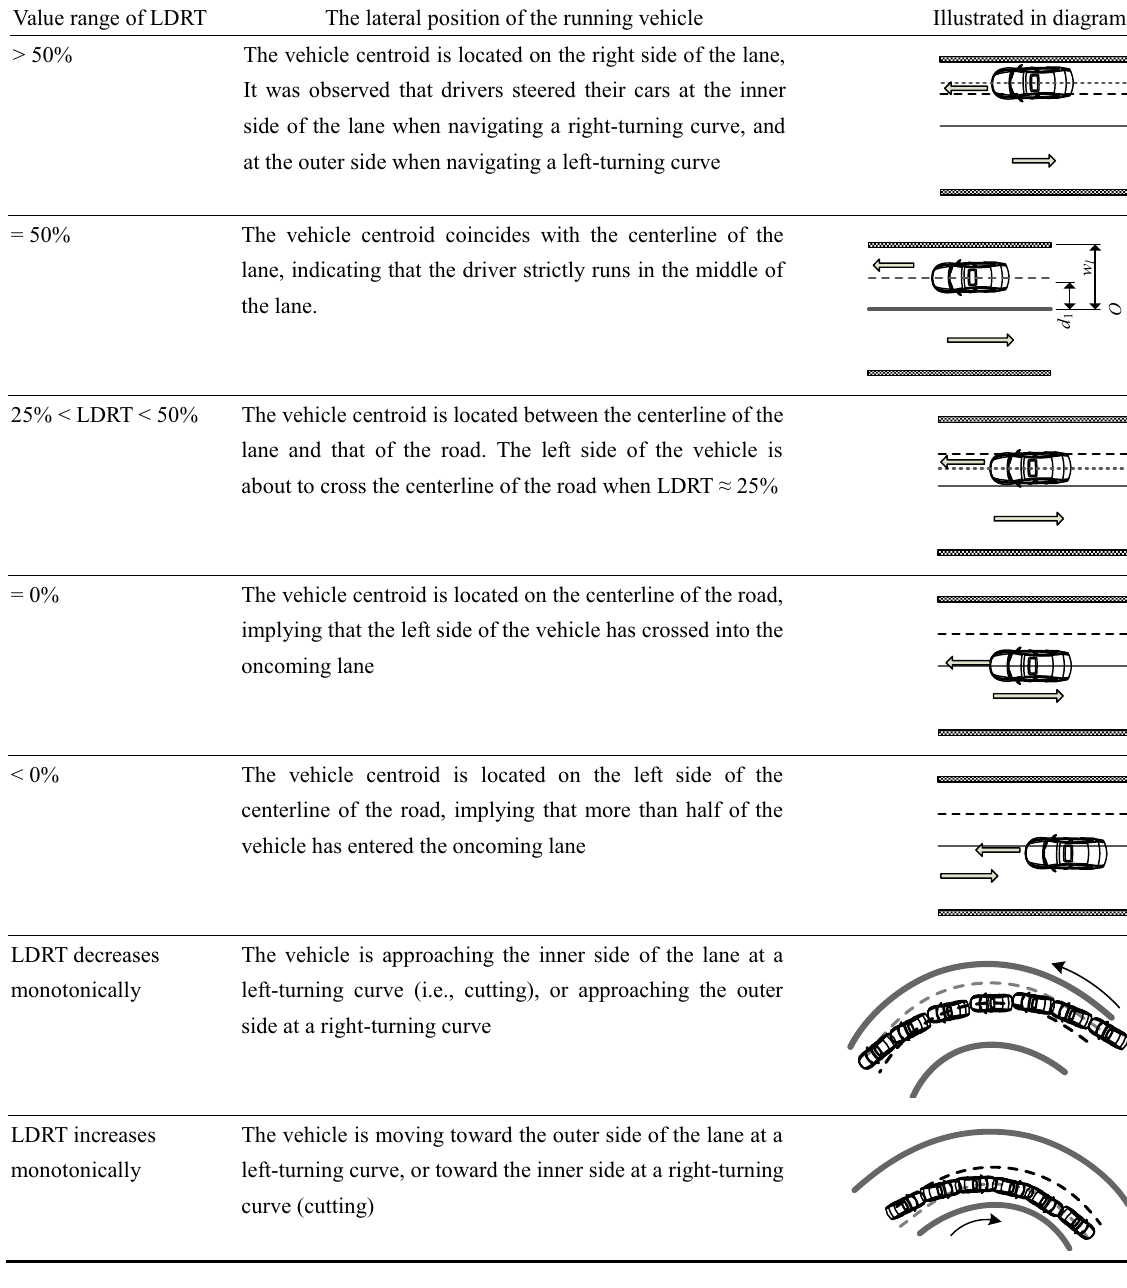
Schematic illustration of lateral deviation rate of trajectory (LDRT) Value range of